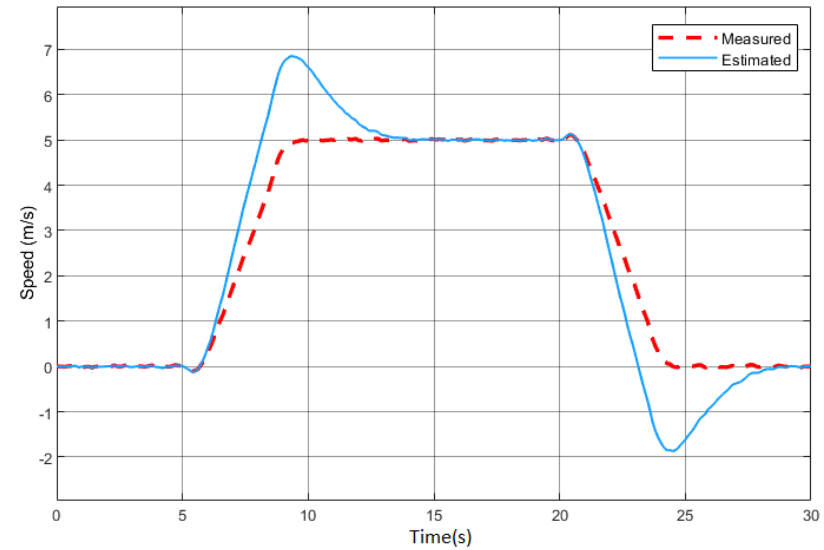
Figure 10. Velocity estimation.